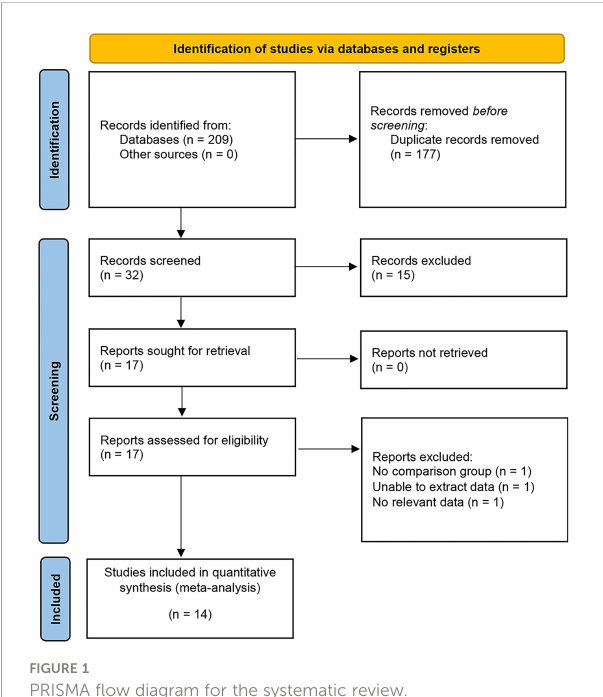
FIGURE 1 PRISMA fl ow diagram for the systematic